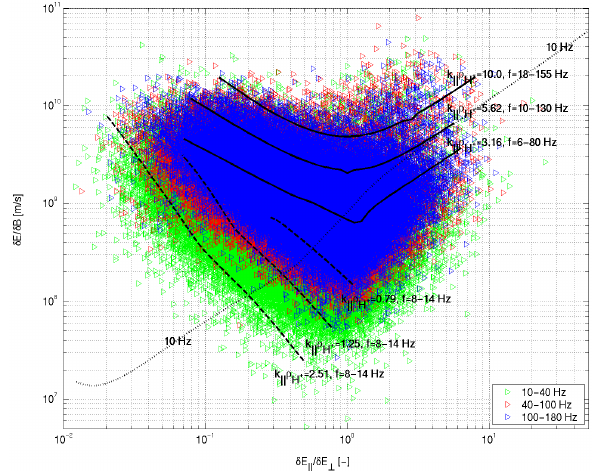
Fig. 3. The 40-min time period in Fig. 1 is divided into sub-intervals of 0.1s using a standard FFT. Different colours correspond to dif- ferent frequency intervals. Green and red dots are present but not visible beneath the blue dots. The lines are theoretically estimated as δ E/ δ B ratios for different frequencies and different k-vectors. See text for details.